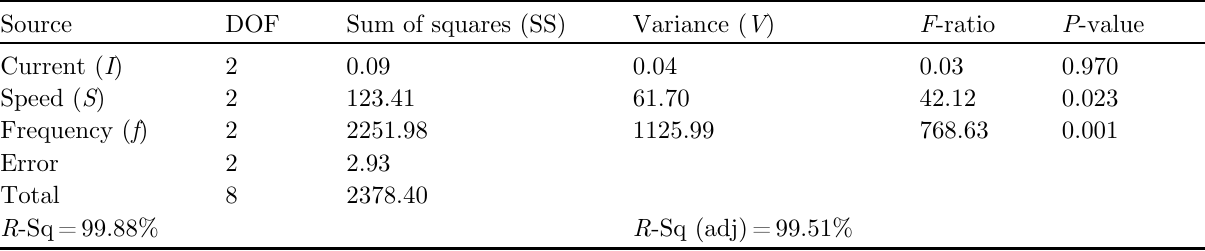
Table 6. Analysis of variance for hardness of L